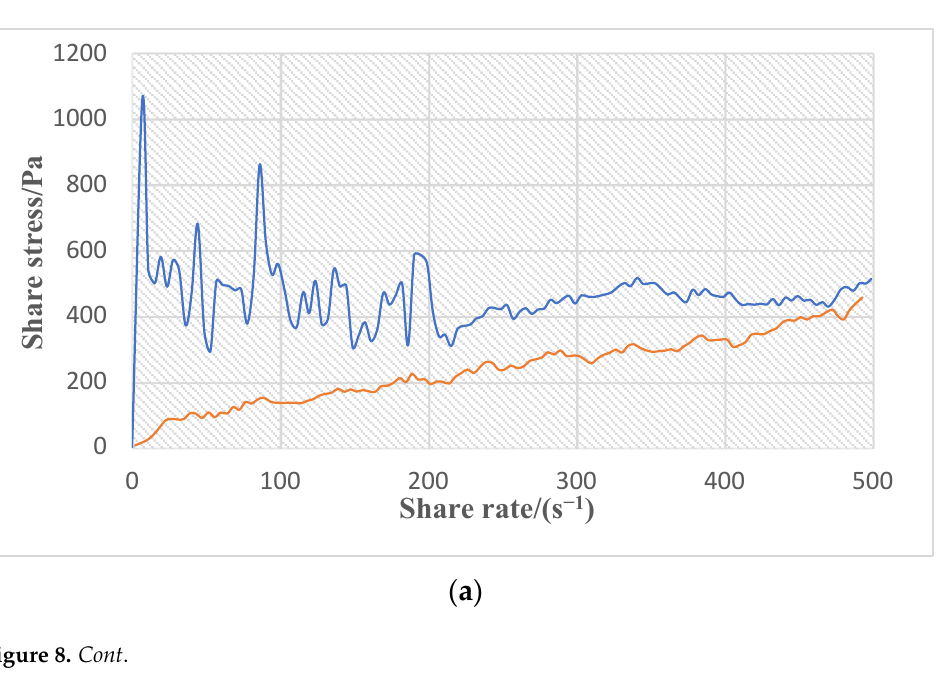
Figure 7. Lubrication additive thixotropic ring: ( a ) PTFE; ( b ) Graphene; ( c ) CNTs; ( d ) WS 2 .